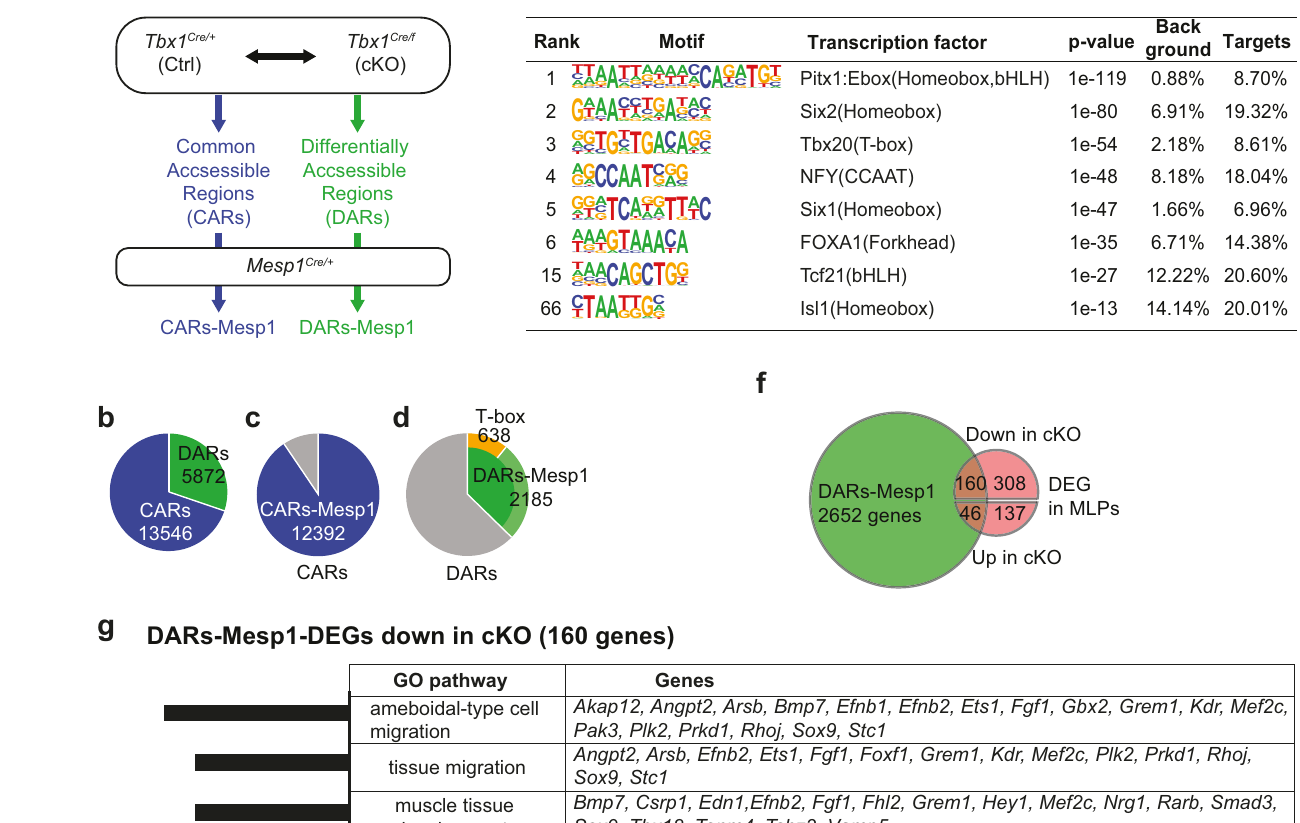
no DARs-Mesp1-DEGs down in cKO (308 genes)